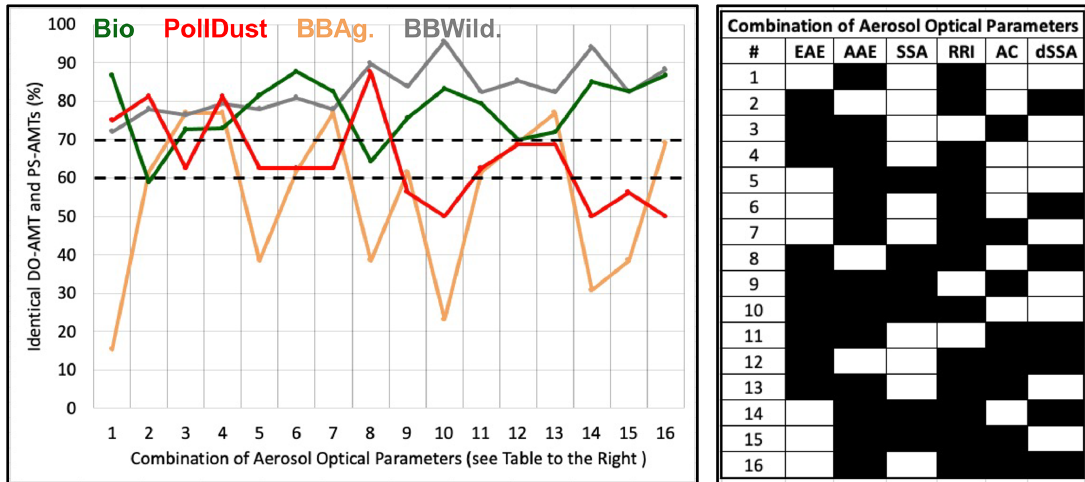
Figure 8. Identical DO-AMTs and PS-AMTs as a percentage of prescribed PS-AMTs in each category when using the different combinations of optical parameters listed in the table to the right (black squares show combination on each line) and for the four PS-AMTs BBAg. (salmon), BBWild. (grey), Bio. (green) and PollDust (red). Black horizontal dashed lines show 60% and 70% identical DO-AMT and